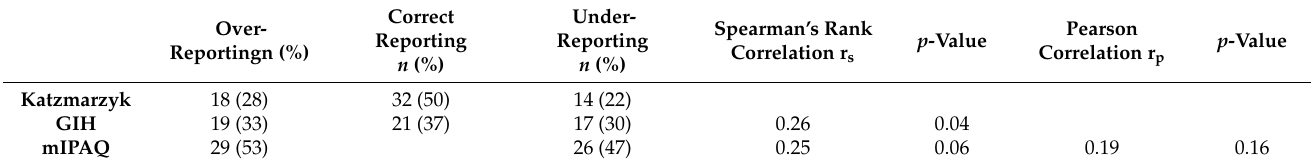
Table 2. Frequency of over-reporting (self-report > sensor-based), correct reporting (self-report = sensor-based), and under-reporting (self-report < sensor-based) for the three different questions compared to ActivPAL.